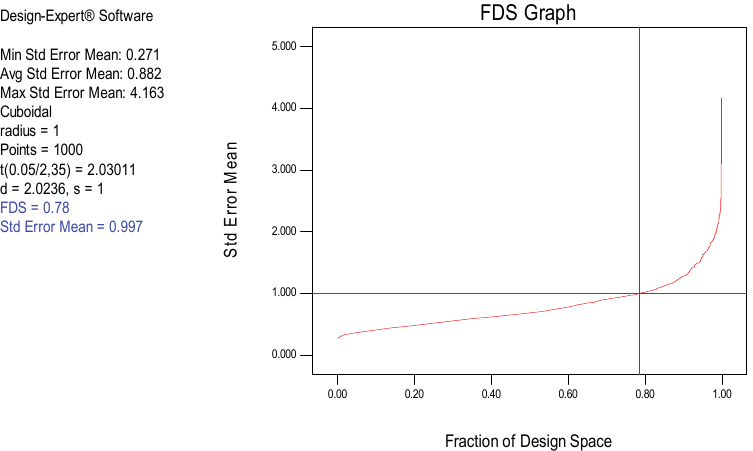
Fig. 2. Fraction of design space plot for Small CCD with 48